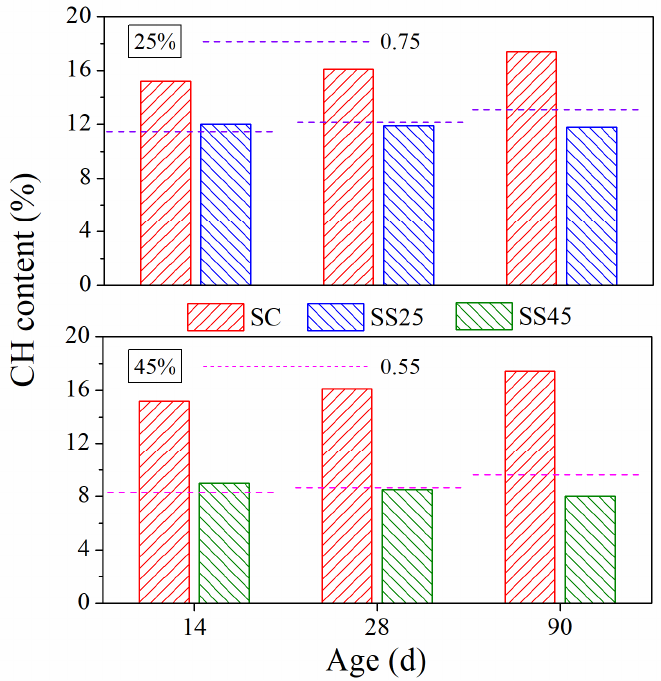
Figure 11. CH content of hardened pastes under standard curing conditions.